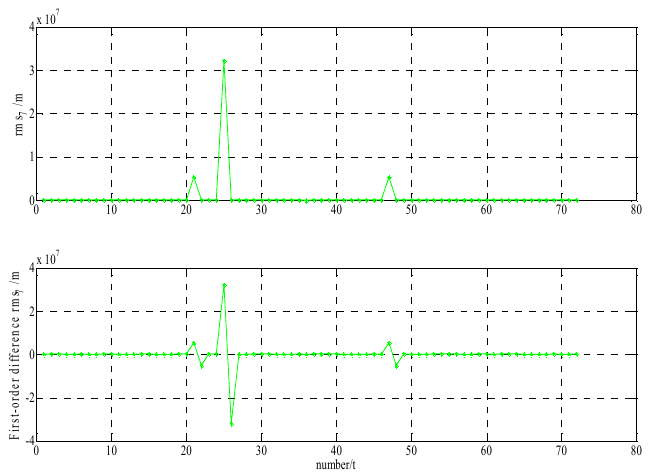
( ) rms t and . ( ) rms t and 7 7 ( ) rms t and 7